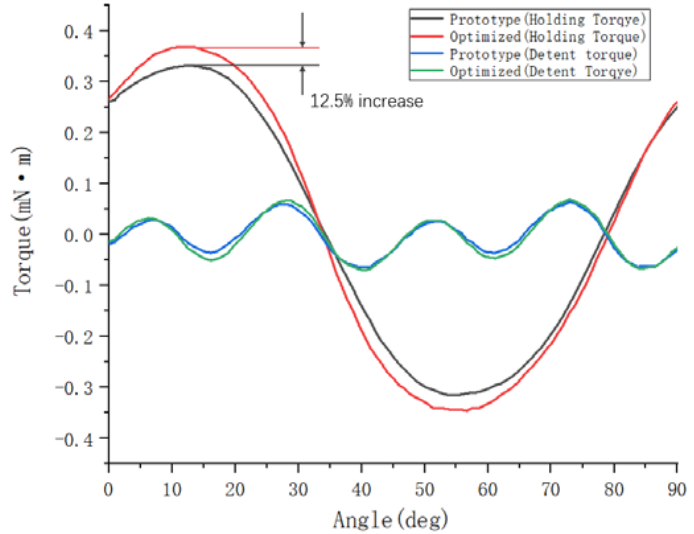
Figure 11. Comparison diagram before and after torque optimization.